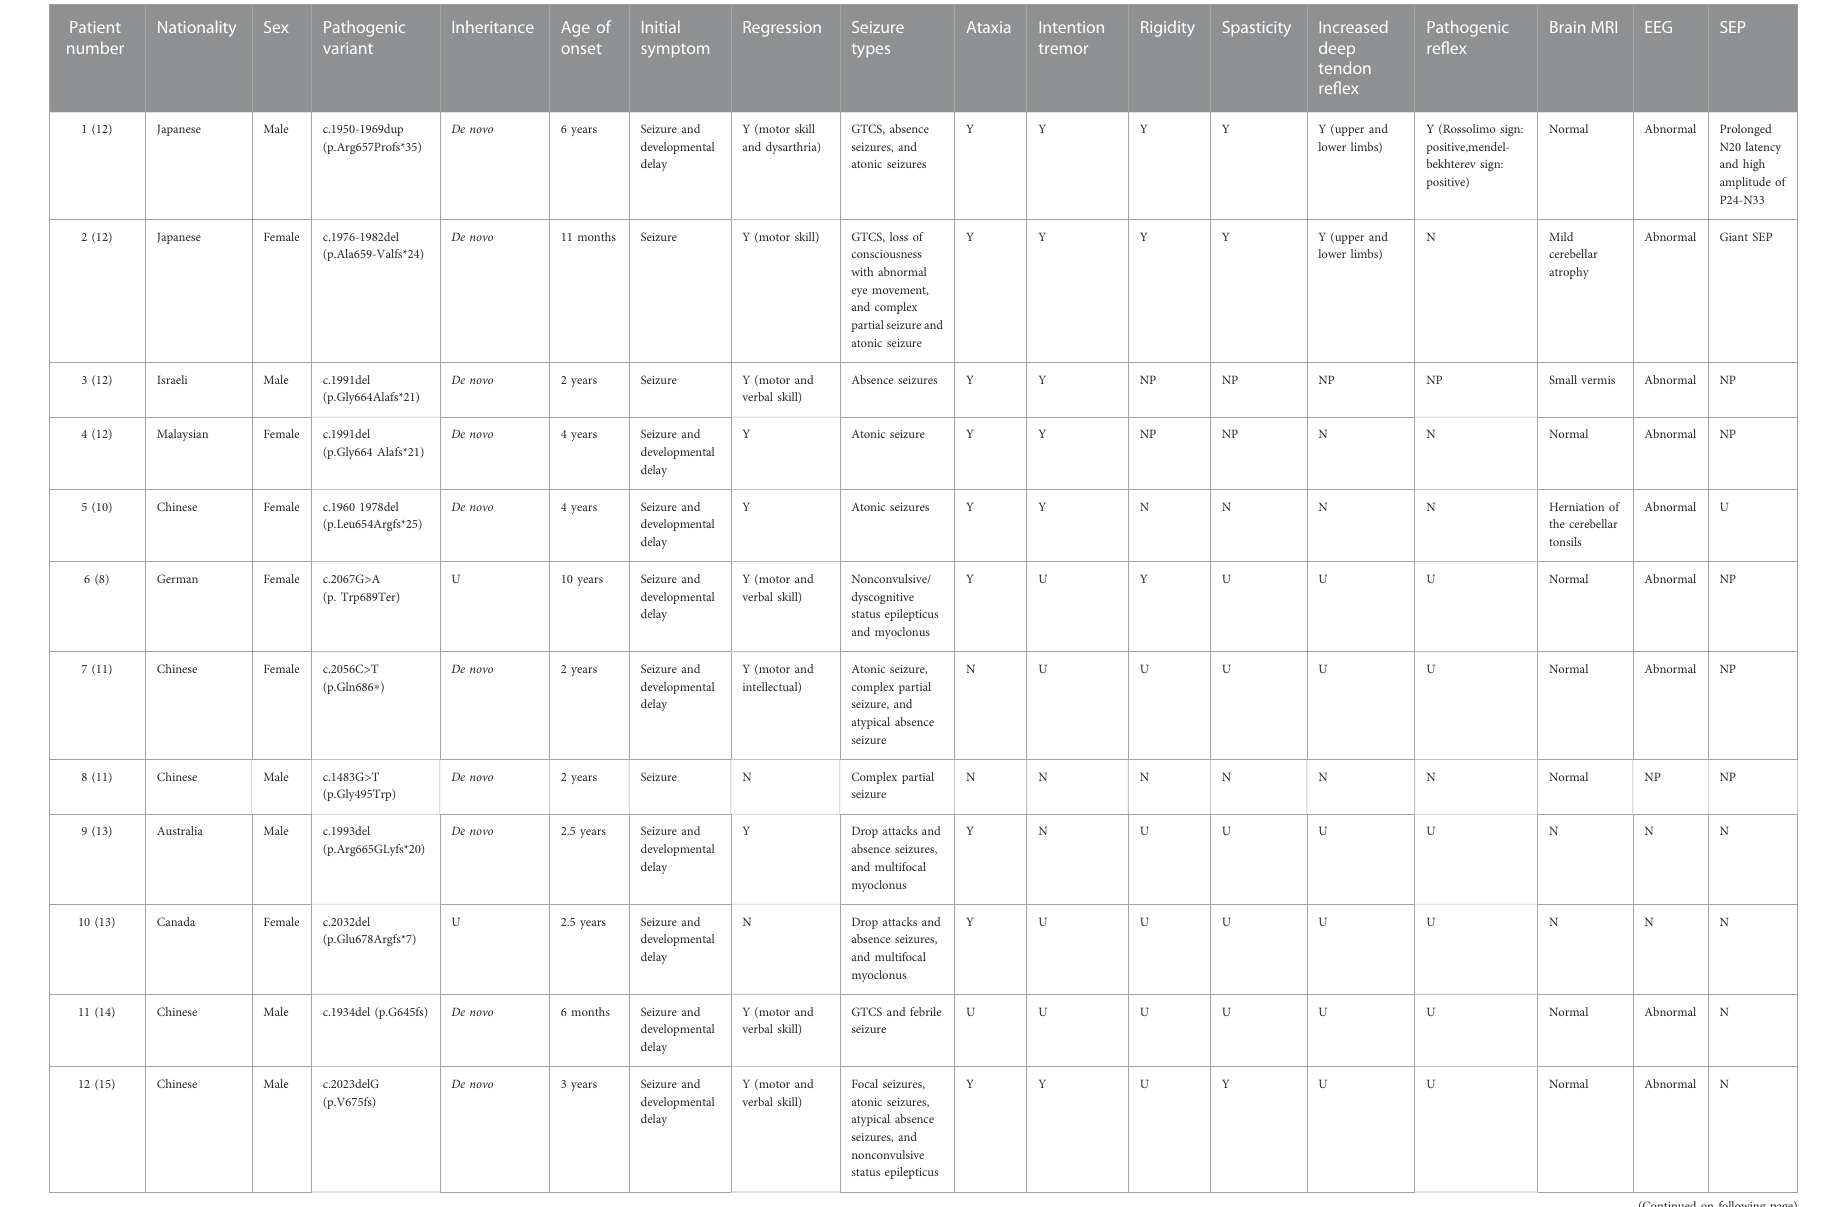
TABLE 1 Clinical features of the patient reported in this work and comparison with published cases of SEMA6B-related progressive myoclonic